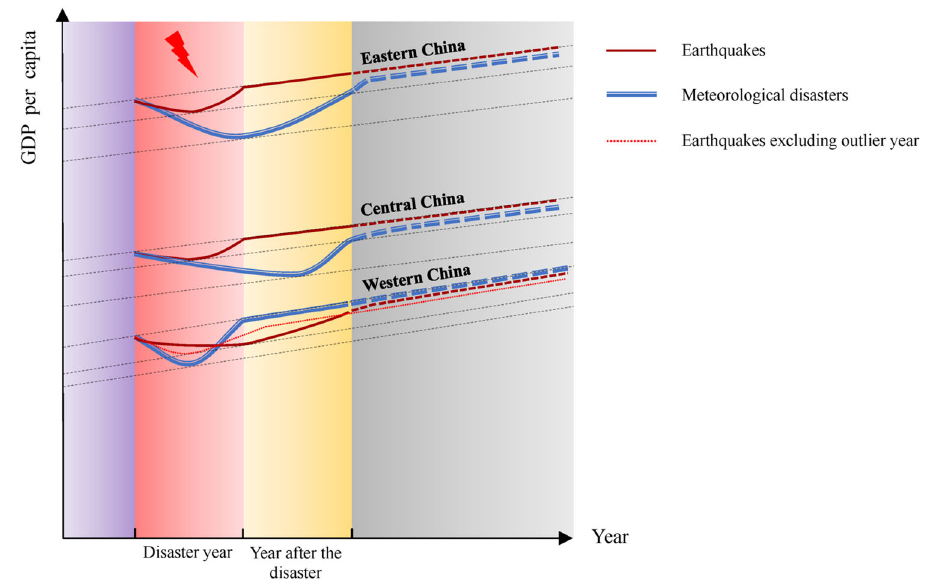
Fig. 3 Scenarios of the short-term per capita output impact of meteorological disasters and earthquakes in the western, central, and eastern regions of China. The slope of the dotted lines represents the current average GDP growth rate in each region. The points tangent to